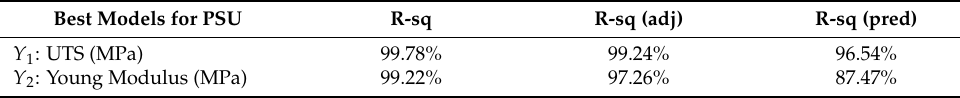
Table 4. Coefficient of determination for fitted models outputs ( Y s ).